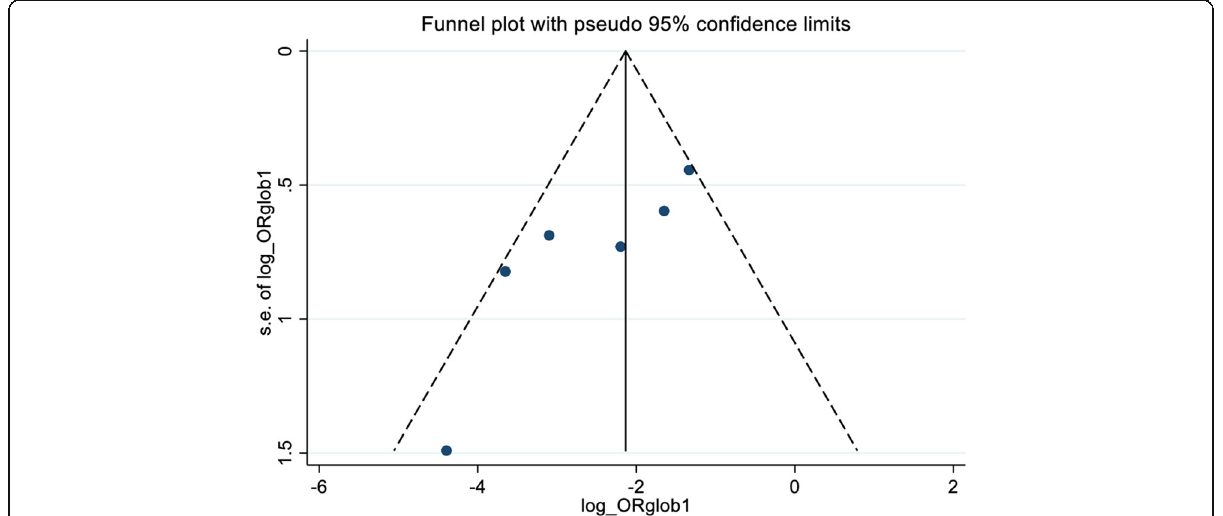
Fig. 4 Publication bias funnel plot (with 95% confidence